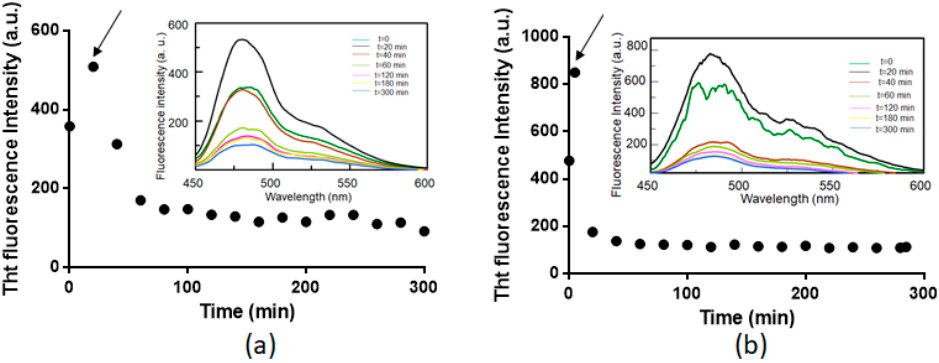
Figure 4. Time course of ThT fluorescence emission intensity of NPM1 264–277 ( a ) and Sup35p 7–13 ( b ) upon the addition of 1 . The time of addition of 1 is indicated by an arrow. In the inset, an overlay of the spectra at indicated times are reported.